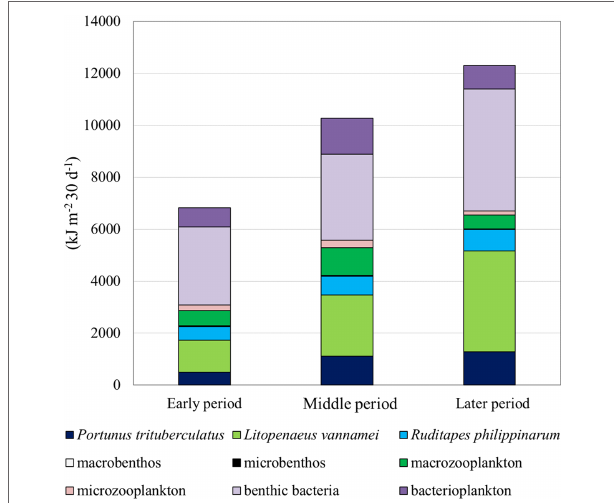
FIGURE 1 | Allocations of total consumption (kJ m -2 30 d -1 ) of each consumer for a Portunus trituberculatus polyculture ecosystem during the early, middle, and late periods,